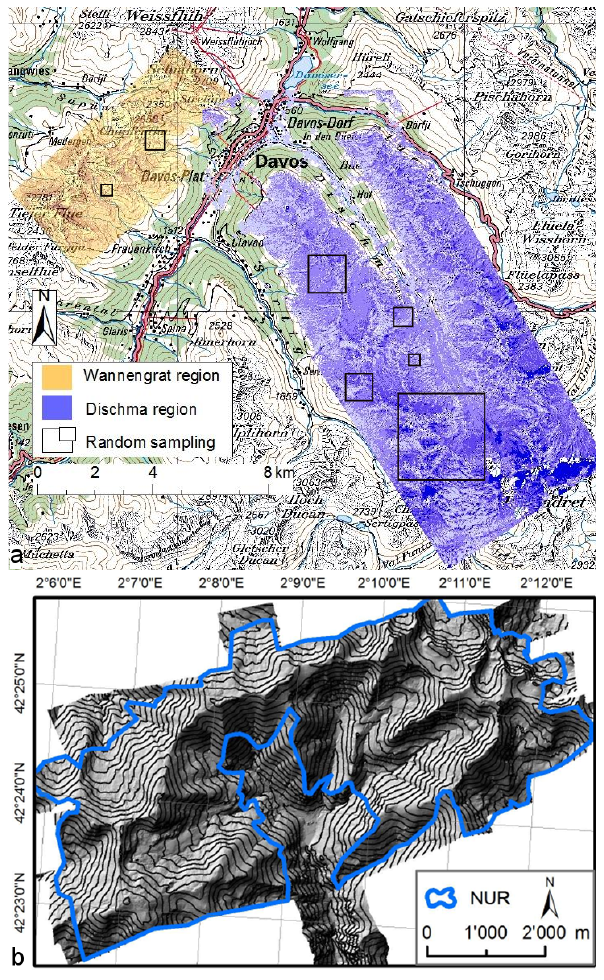
Figure 1. Maps of (a) measured snow depths at Wannengrat and in the Dischma area in the eastern Swiss Alps and (b) hillshade at Val de Núria in the eastern part of the Spanish Pyrenees. The black squares illustrate examples of our randomly selected domain sizes of varying size. The underlying pixelmap (1 : 2000000) in (a) stems from swisstopo ©2008. The picture in (b) is taken from Grünewald et al. (2013).